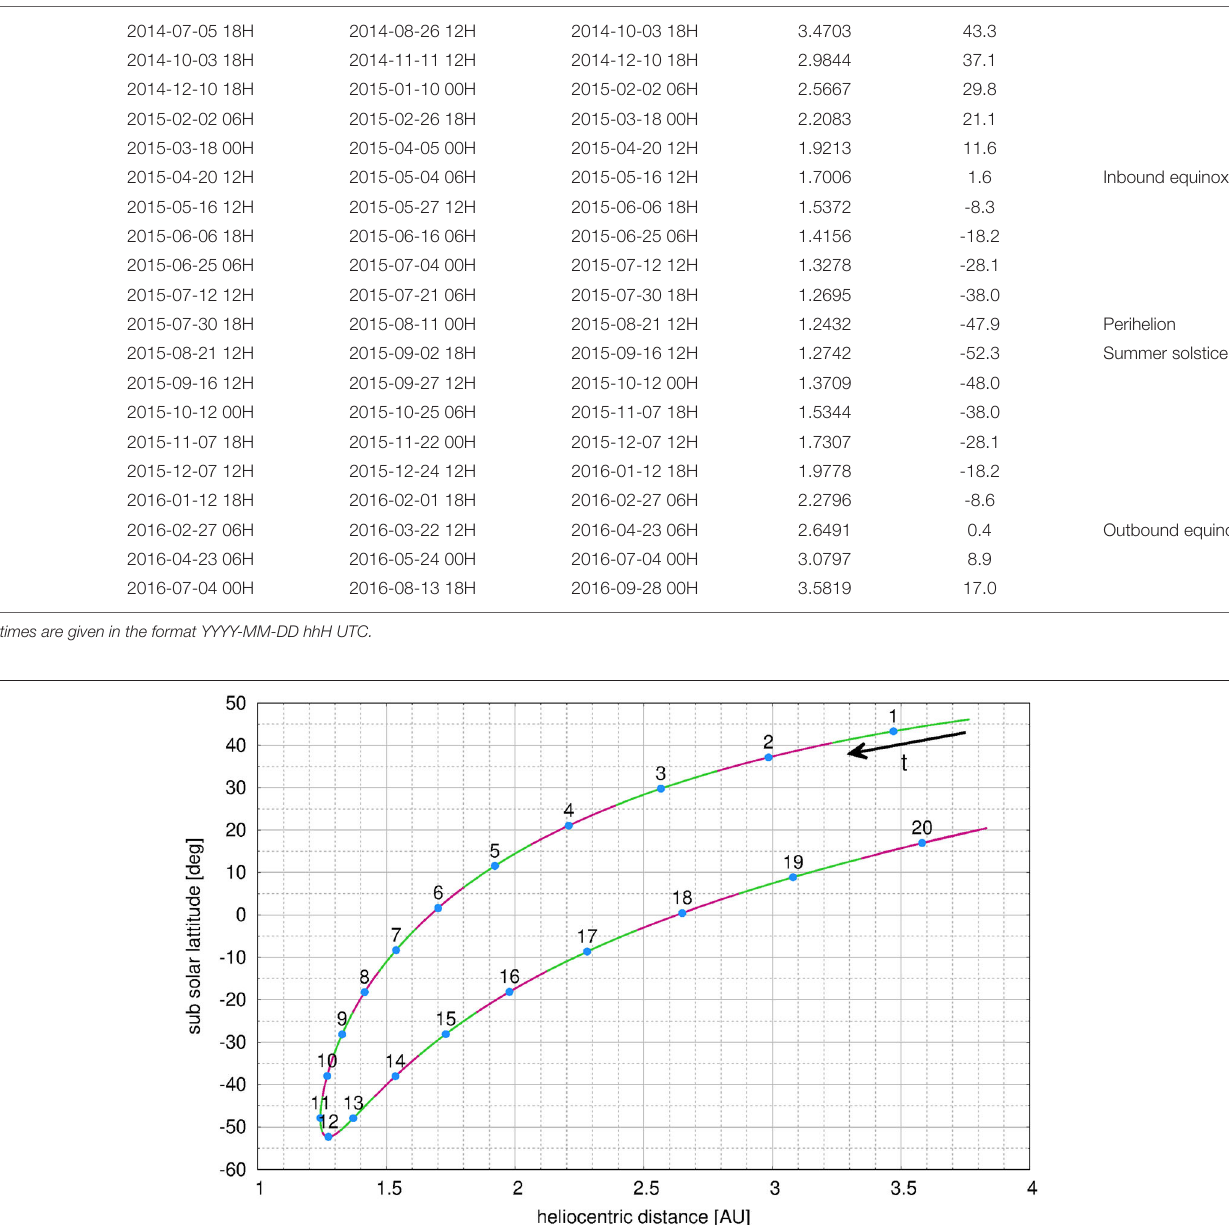
67P. Here we assume a pure H 2 O ice surface that is areally mixed with inert refractory surface akin to a checkerboard pattern. This surface fraction of the facet covered by ice, which is a priori not known, is a free parameter of the model. We refer to this scaling factor as the effective active fraction (EAF). This factor only has a physical interpretation for a pure ice surface where it would represents the fraction of pure ice of an areally mixed surface